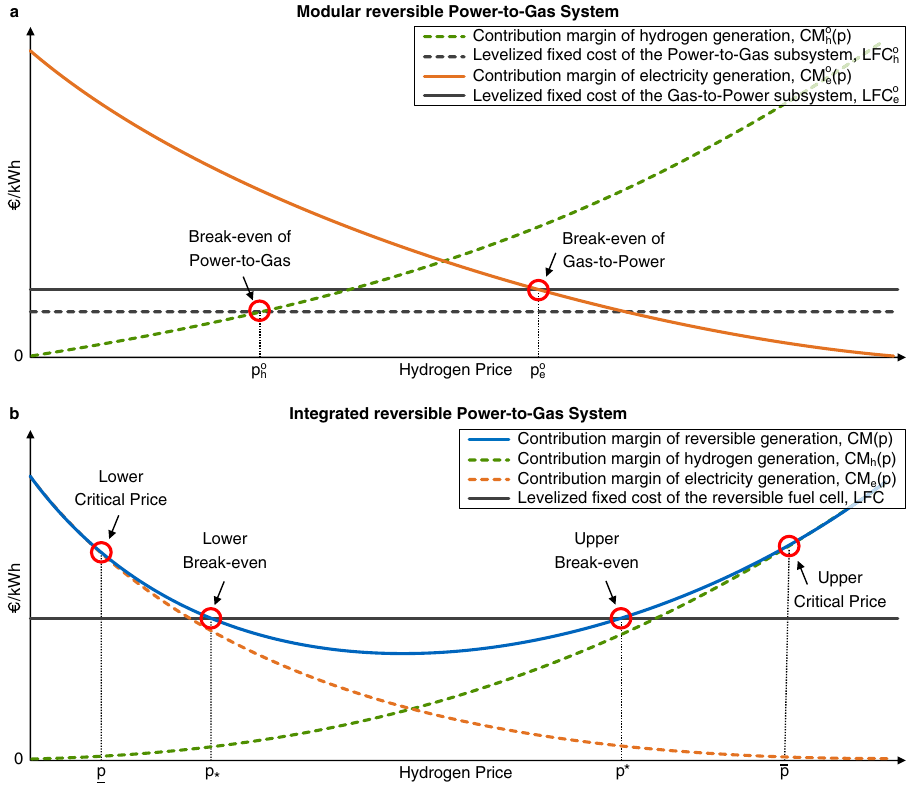
Fig. 2 Economics of a reversible Power-to-Gas system. The fi gure illustrates the potential cost-competitiveness and value of reversible operation in terms of the respective break-even prices of ( a ) a modular reversible Power-to-Gas system, and ( b ) an integrated reversible Power-to-Gas